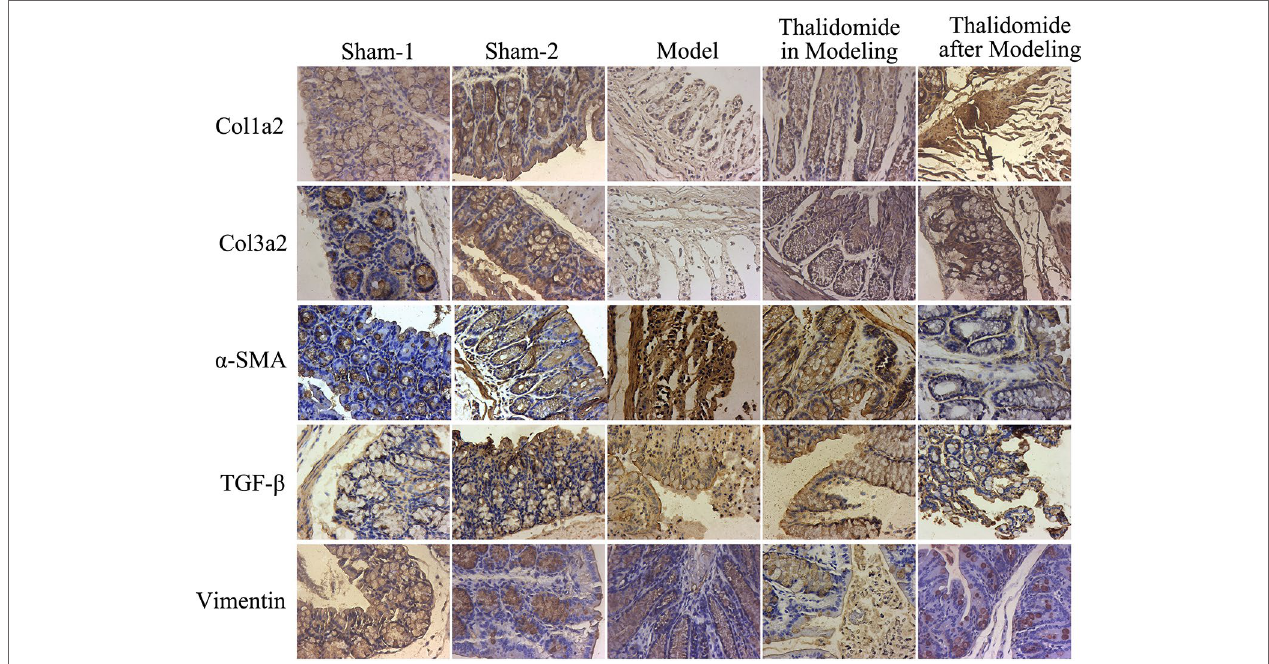
FIgURe 6 | Immunohistochemical assay was performed to evaluate the expression levels of fibrosis-related proteins in mice from different groups. TNBS induction could significantly increase the expressions of col1a2, col3a2, TGF-β and α-SMA while decrease the expression of Vimentin, and thalidomide treatment could reverse the